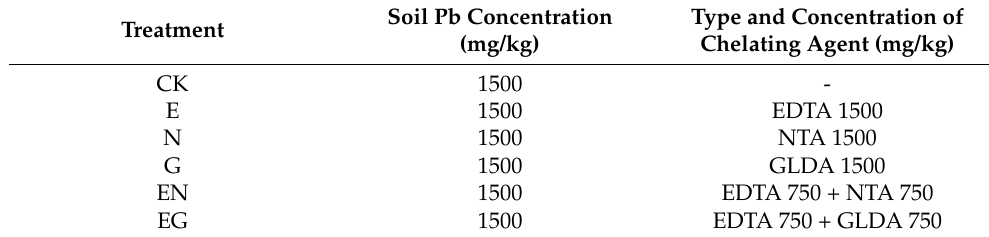
Table 1. Soil treatment with chelating agents.